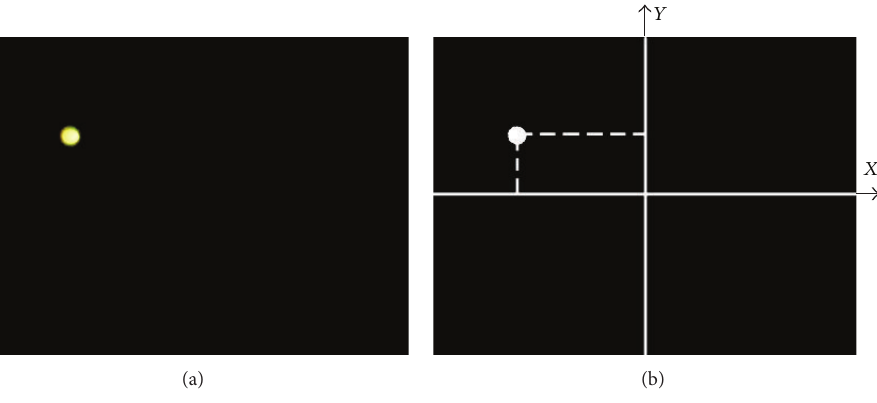
Figure 3: Acquisited (a) and processed (b) image.